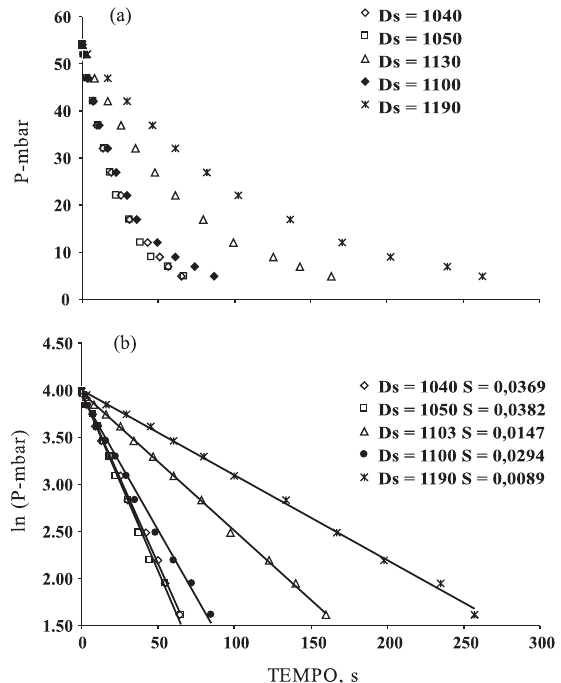
E2.Figura 5. Relação entre decréscimo da pressão versus tempo para algumas amostras indeformadas de solo do estudo E2. Relação observada experimentalmente (a) e relação linearizada (b), em que é obtida inclinação S (em módulo) utilizada no cálculo da permeabilidade ao ar. Ds: densidade do solo (kg m -3